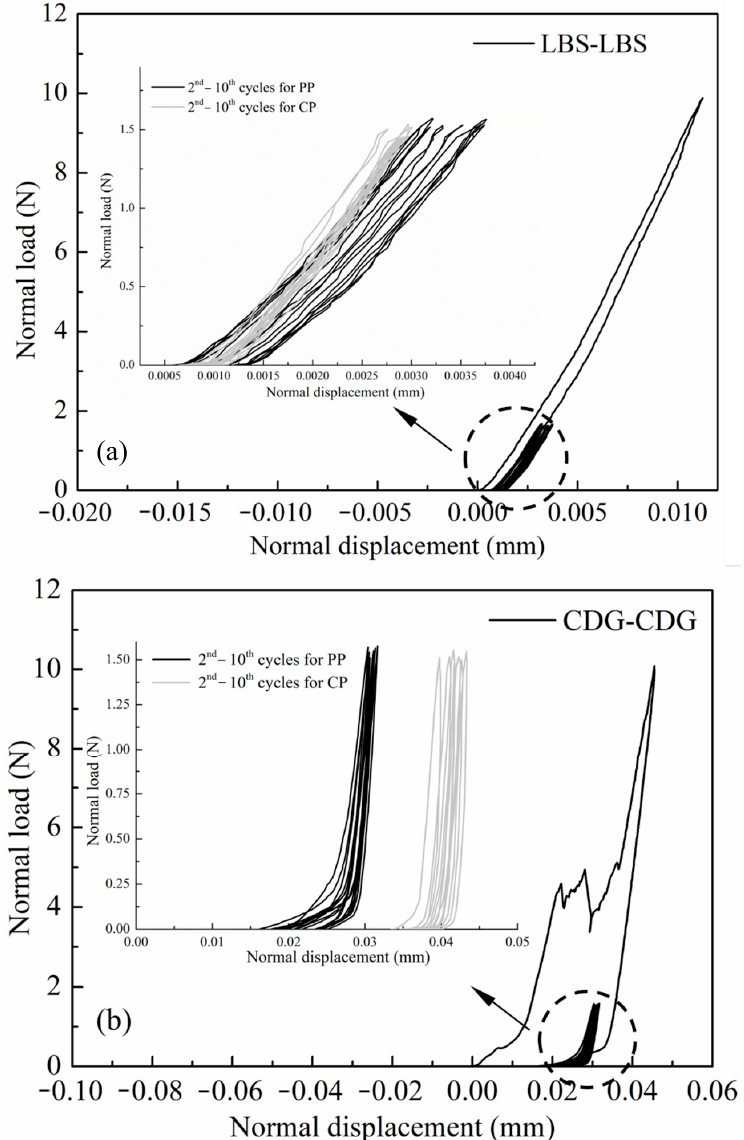
Figure 11. Load–displacement curves of preloading for ( a ) LBS–LBS and ( b ) CDG–CDG contacts and their comparisons with cyclic tests (inset Figures).